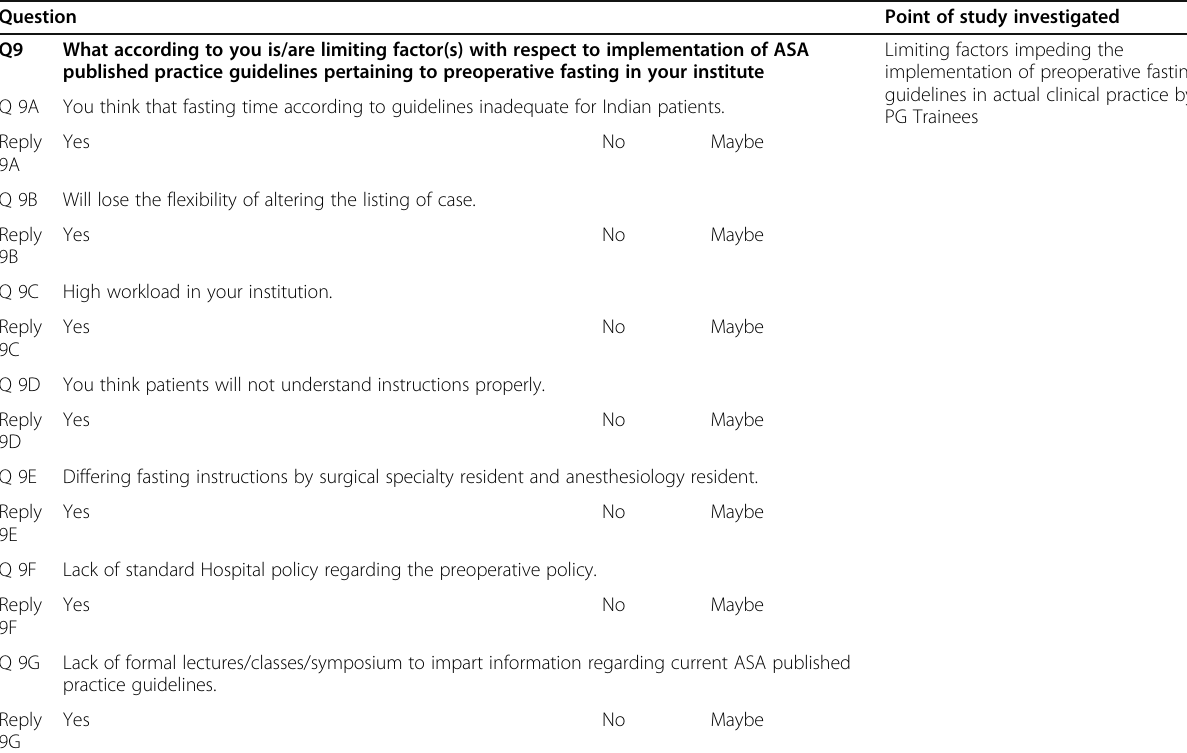
Table 1 Questionnaire with list of questions (Continued) Question Point of study investigated